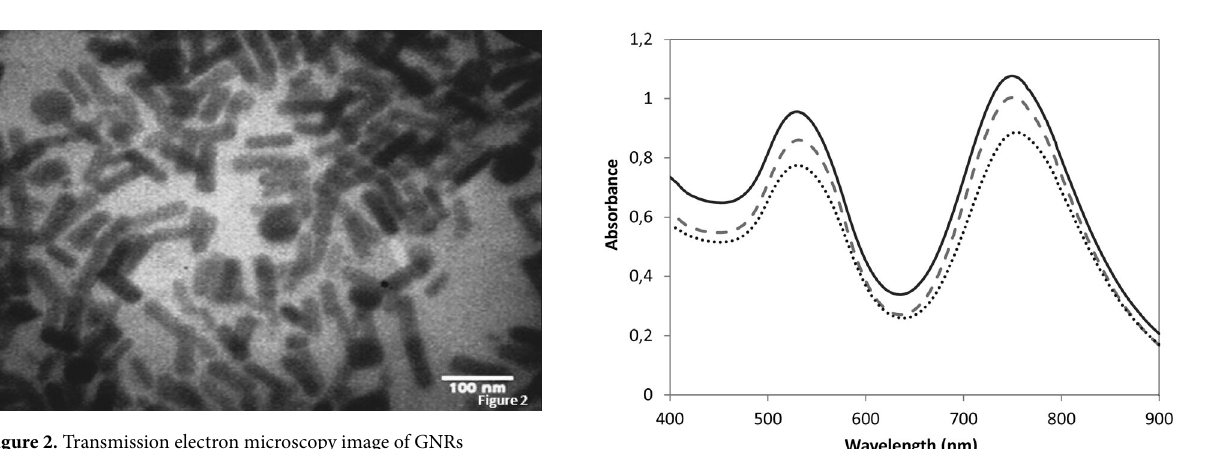
Figure 2. Transmission electron microscopy image of GNRs